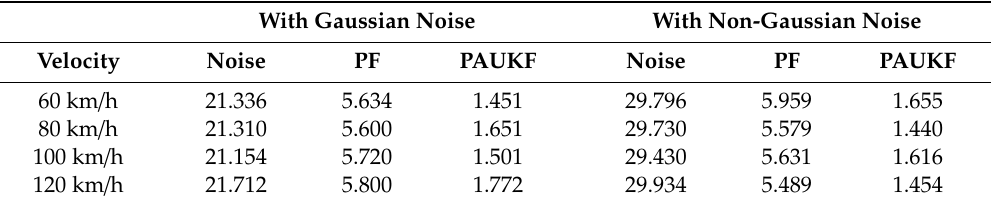
Table 4. Total Root Mean Square Error (RMSE) of filters in di ff erent conditions (unit: m). With Gaussian Noise With Non-Gaussian Noise Velocity Noise PF PAUKF Noise PF